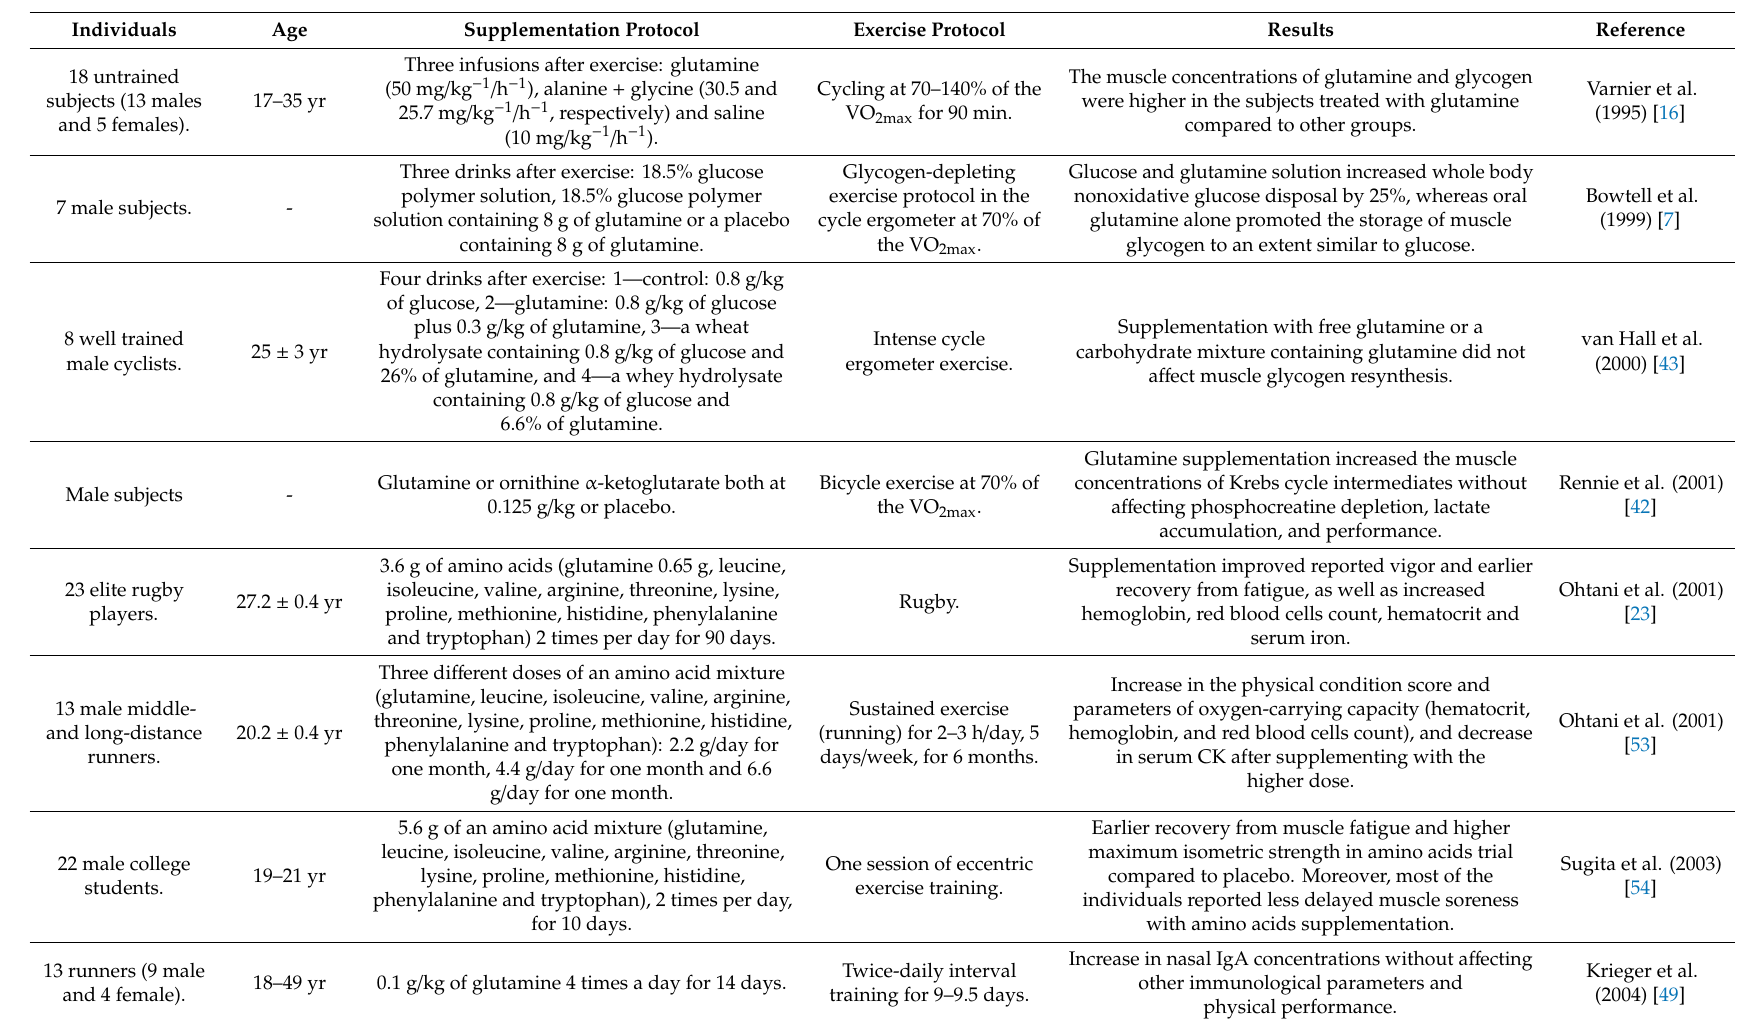
Table 1. Human studies involving glutamine administration and fatigue markers (chronological